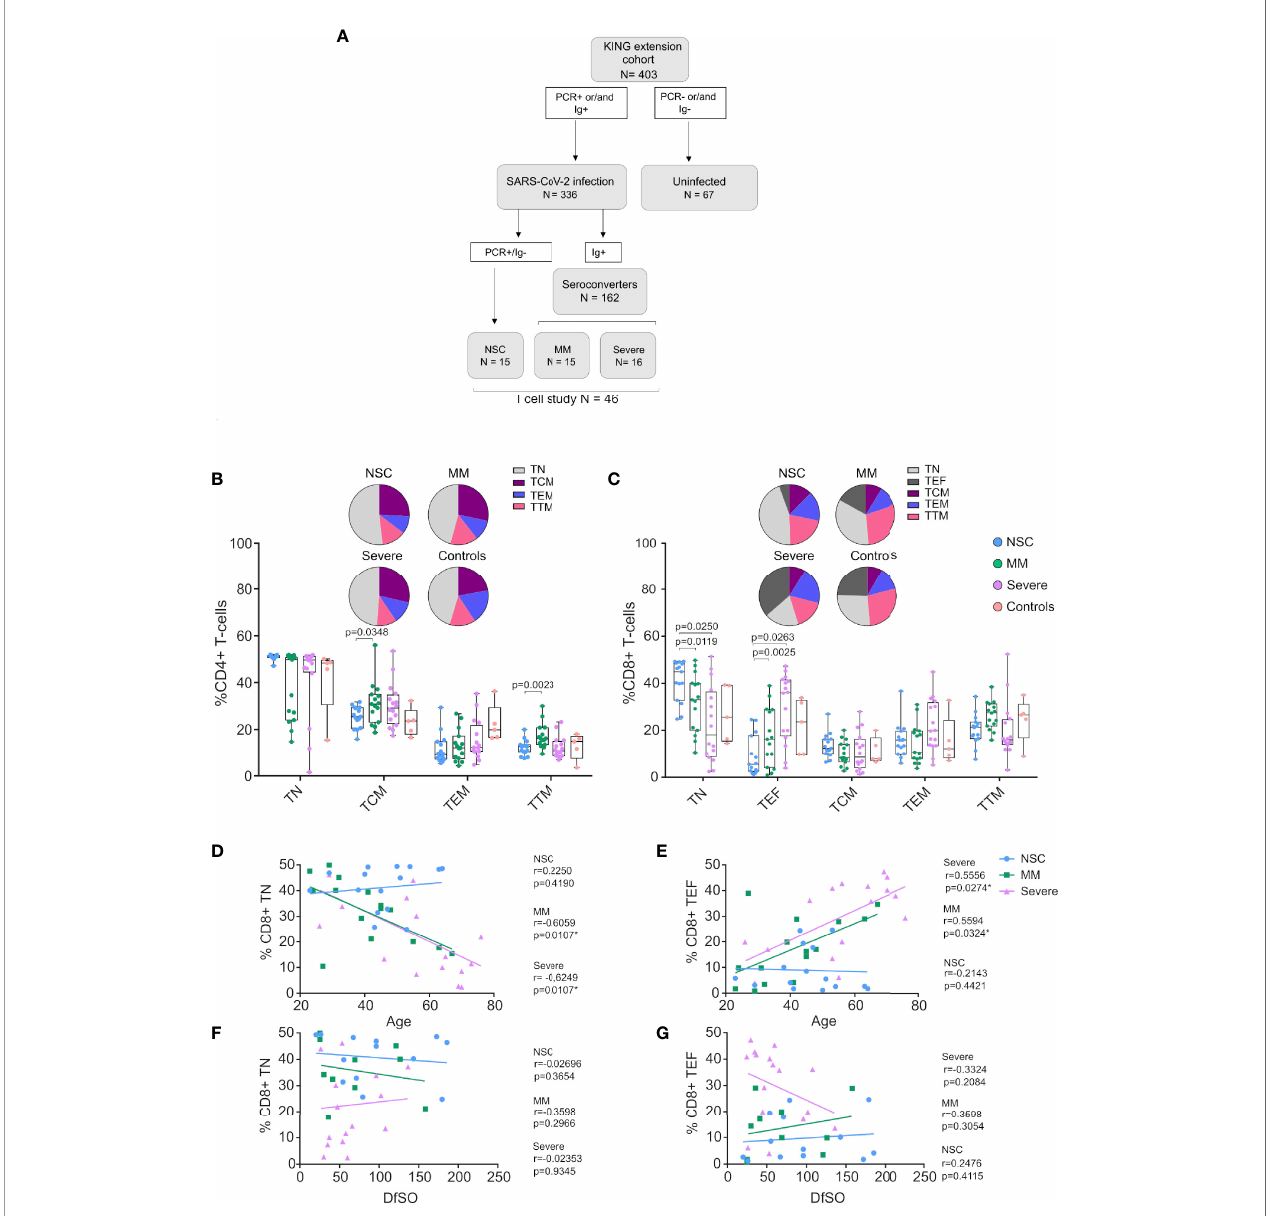
FIGURE 1 | CD4+ and CD8+ T-cell subset distribution in Non-Seroconvertors. (A) Flow chart of the study groups, including Non-Seroconvertors (NSC), Mild- moderate (MM), Severe (B, C) Cryopreserved PBMCs were cultured and surface stained with antibodies targeting CD4 and CD8 as well as T-cell lineage markers CD45RA, CCR7, CD27 to distinguish T-central memory cells (TCM), T effector memory cells (TEM), T transitional memory cells (TTM), T Naïve cells (TN) and T effector cells (TEF). Cells were pre-gated for lymphocytes and live cells. Whisker plots show the frequencies of CD4+ T-cell subsets and pie charts represent the frequency distribution of CD4+ and CD8+ T-cell subsets in each group (Panel B, C , respectively). Statistical analyses were performed using a multivariable regression analysis. Only signi fi cant values are indicated in the Figure. Linear regression was performed plotting relative frequencies of CD8+ TN (D) and CD8+ TEF (E) against the age of the study participants, as well as relative frequencies of CD8+ TN (F) and CD8+ TEF (G) against the Days from Symptom Onset (DfSO) to sample. Correlation analyses were performed using Spearman ’ s rank correlation test; r- and p-values are reported for each